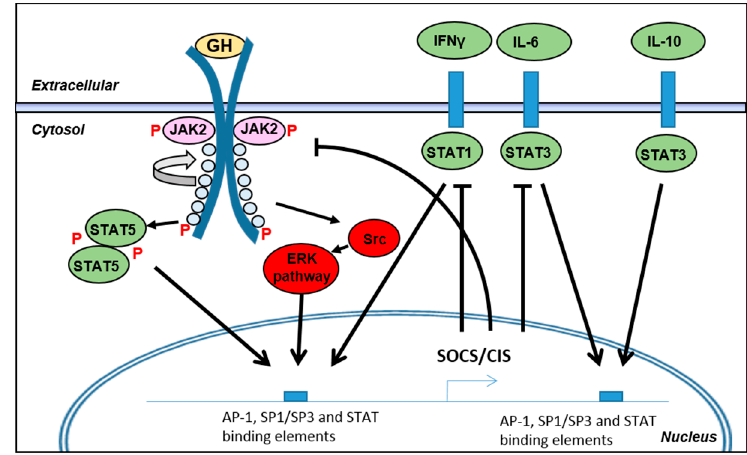
Figure 5. Regulation of GHR mediated signaling. During inflammation multiple cytokines elicit cellular signaling through their respective receptors. In order to regulate cytokine signaling negative feedback loops exist which includes the family of suppressor of cytokine signaling (SOCS) proteins including SOCS1–7 and CIS (cytokine-induced STAT inhibitor). The SOCS proteins target the receptors for proteolysis and limits phosphorylation of signaling intermediates. GHR signaling itself induces SOCS expression (mainly SOCS1 and 3) to terminate its own signaling. Several inflammatory mediators also induce SOCS expression which in turn creates an increased negative impact on the GHR signaling. IL-10 functions as an anti-inflammatory cytokine—note that IL-10 induces SOCS expression but is not itself inhibited by their expression whereas pro-inflammatory cytokine receptors are. IL-6 is the best described cytokine to negatively impact GHR signaling. GHR, accordingly, appears to be impacted by the endogenous regulatory systems in place to prevent excessive cytokine signaling. Arrows and blocked arrows indicate inducing and inhibiting actions, respectively, of the SOCS/CIS negative feedback loop on receptor signaling.